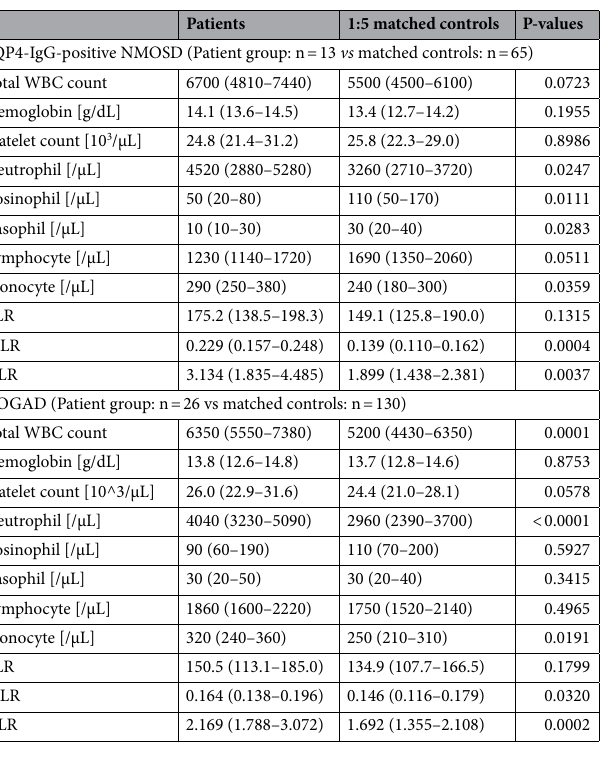
Table 1. White blood cell counts profiles between patients and matched healthy controls in AQP4-IgG- positive NMOSD and MOGAD. Median and interquartile range (25–75 percentiles) for each variable are shown. AQP4 aquaporin-4, MOGAD anti-myelin oligodendrocyte glycoprotein antibody-associated disease, NMOSD neuromyelitis optica spectrum